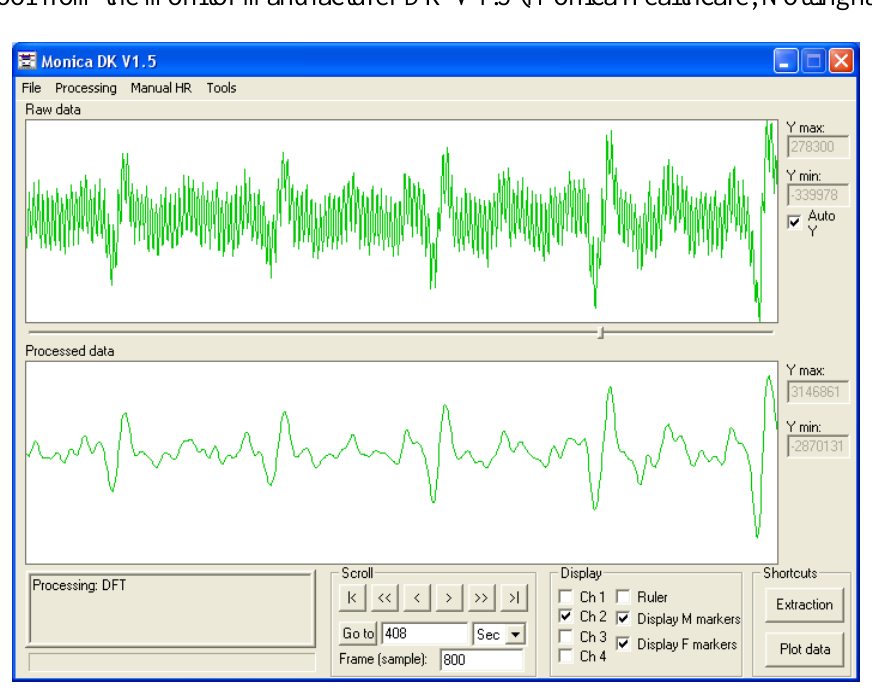
Figure 5. The effects of Finite Impulse Response (FIR) filtering with a standard bandpass filter (4–45 Hz) on the combined mECG and fECG signals which were acquired from a volunteer within the magnet (without imaging applied). ECG data was recorded during the entire imaging session and subsequently downloaded from the device and analysed using a developmental software tool from the monitor manufacturer DK V1.5 (Monica Healthcare, Nottingham, UK).